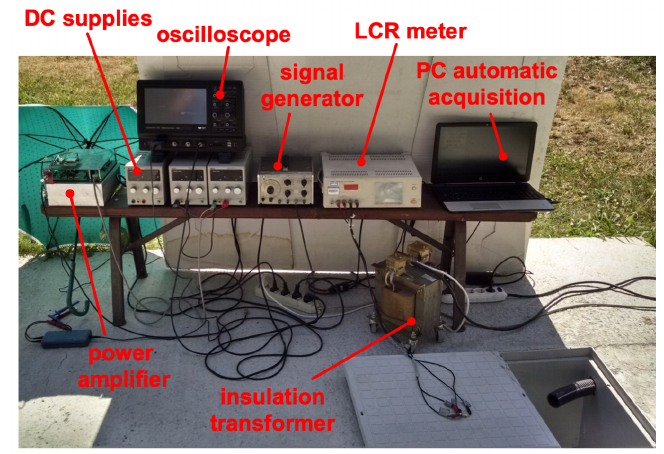
Figure 2. Test setup for the measurement of the embedded coil impedance.